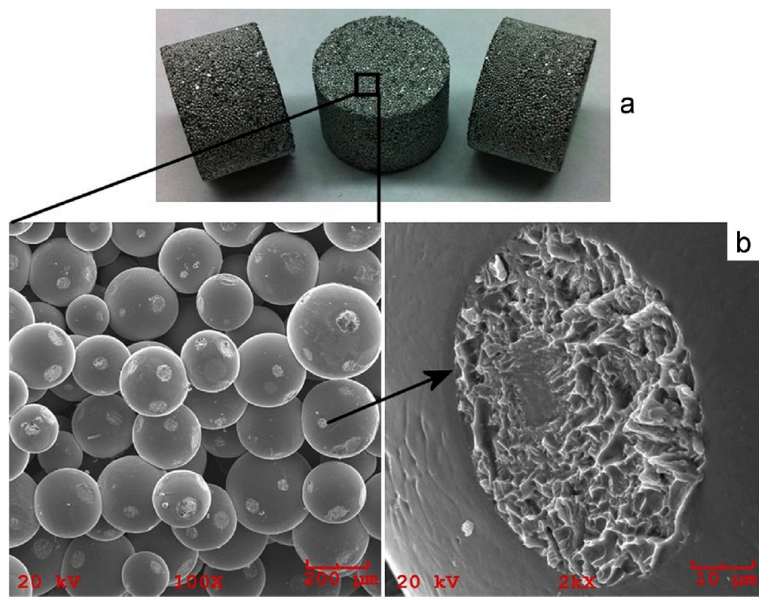
Figure 6. Porous Ti5Al2.5Fe compacts ( a ), contacts between the particles showing dimpled fracture surface ( b ). Reprinted from Yamanoglu et al. [24], Copyright (2016), with permission from Elsevier.